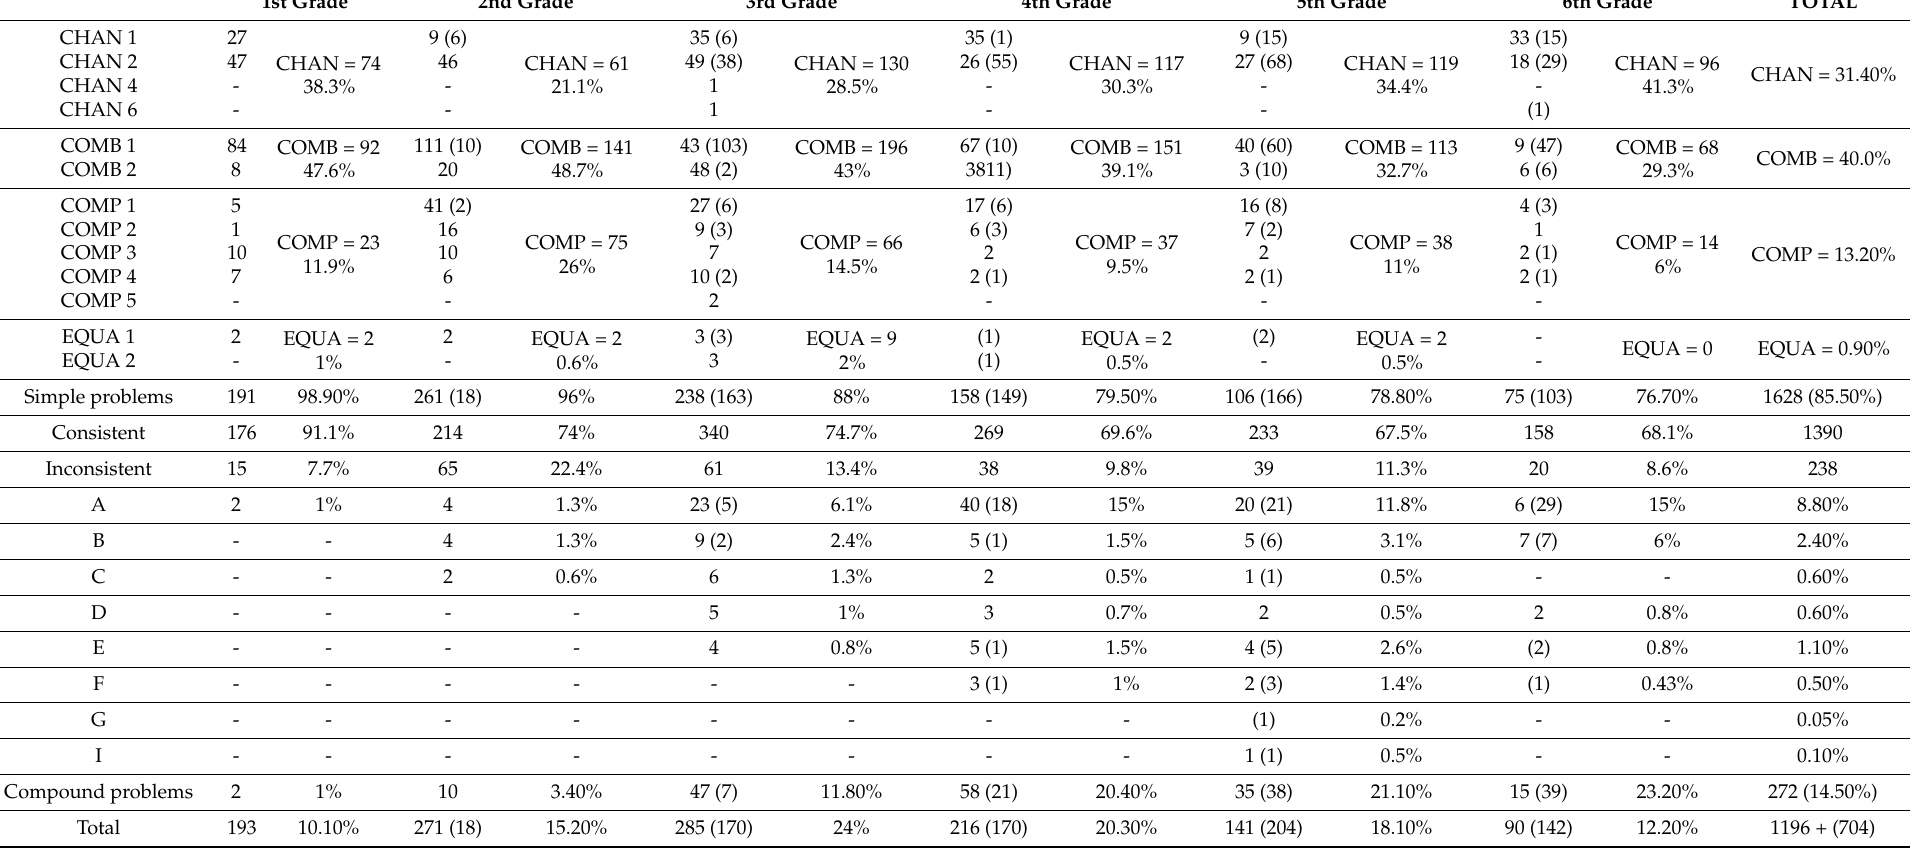
Table 3. Results of the frequency and variability of the problems’ semantic structure by educational